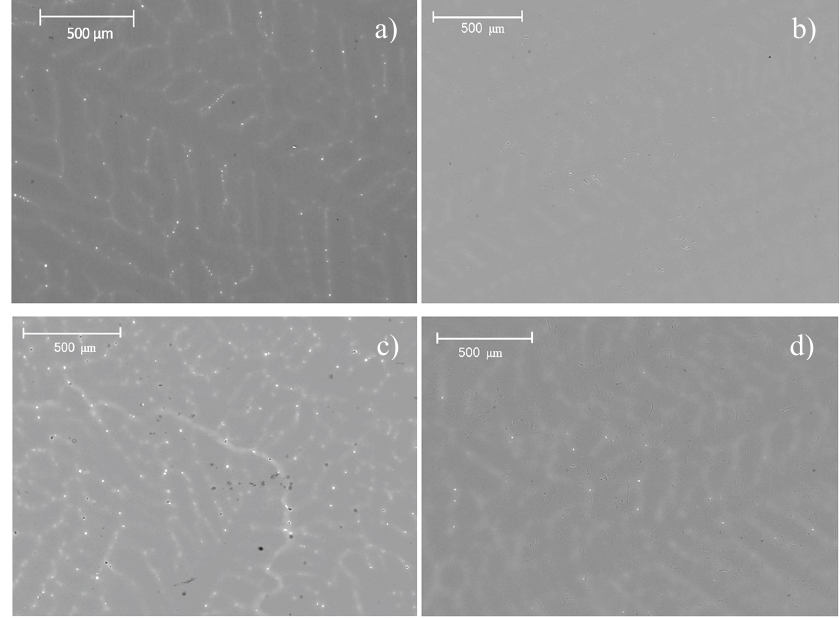
Figure 3. BSE-mode SEM images of the microstructure of the alloys: ( a ) as-cast Mg-1.125Ga, ( b ) heat treated Mg-1.125Ga, ( c ) as-cast Mg-1.5Ga, ( d ) heat treated Mg-1.5Ga.